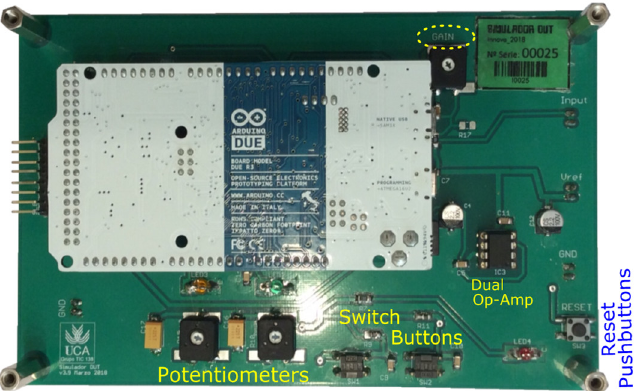
Figure 4. Emulator PCB, bottom side (with a DUE board plugged).